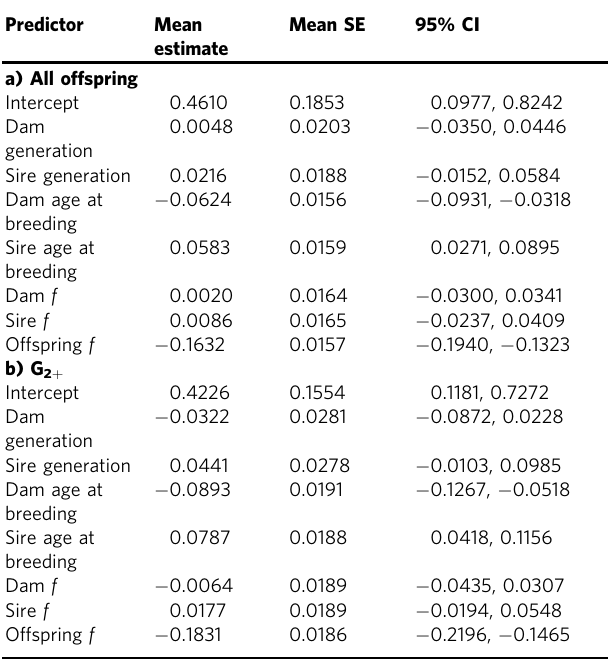
(a) Standardised parameter estimates of pooled ( N = 5) analyses after randomly sampling one independent offspring from each litter and model averaging ( N = 21,282 individuals). (b) Standardised parameter estimates of pooled ( N = 5) independent litter sampling G 2 + analyses ( N = 16,514 – 16,516 individuals, see Methods).